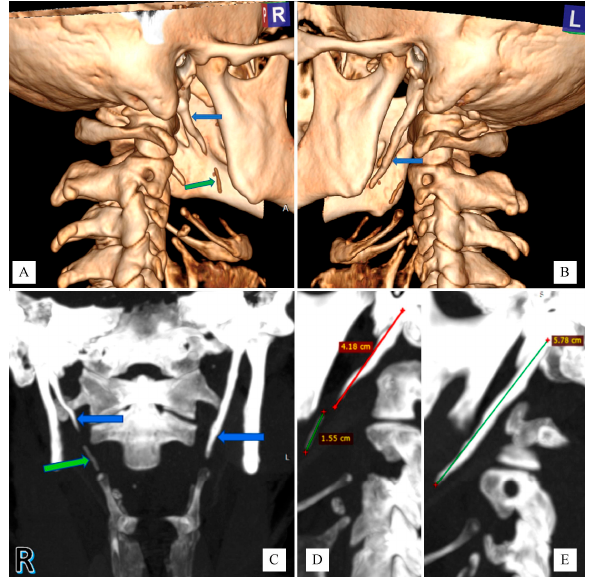
Figure 1. Computed tomography of the neck without contrast agent: ( A ). Volume Rendering Technique (VRT) reconstruction. The elongated right styloid process is marked with a blue arrow. Longitudinal calcification in the extension of the right styloid process is marked by a green arrow. ( B ). VRT reconstruction. The elongated left styloid process is marked with a blue arrow. ( C ). Maximum intensity projection (MIP) reconstruction. Elongated styloid processes are marked with a blue arrow. Longitudinal calcification in the extension of the right styloid process is marked by a green arrow. ( D ). MIP reconstruction. Measurements of the length of the elongated right styloid process and calcification in its extension. ( E ). MIP reconstruction. Measurement of the length of the elongated left styloid process.